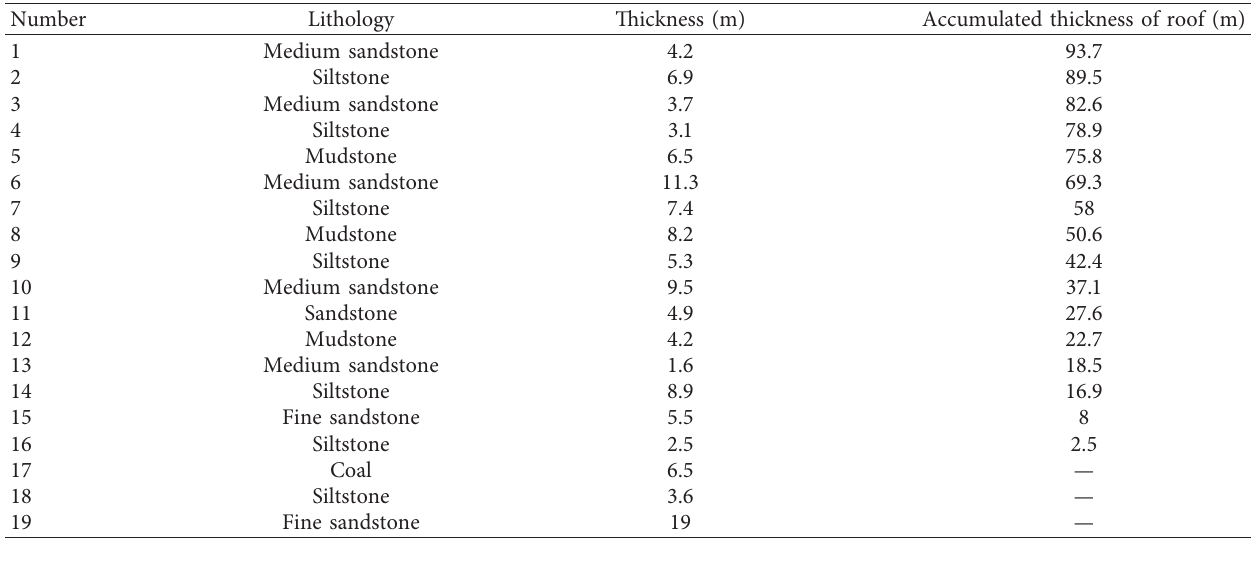
Table 2: Thickness of coal and rock strata.